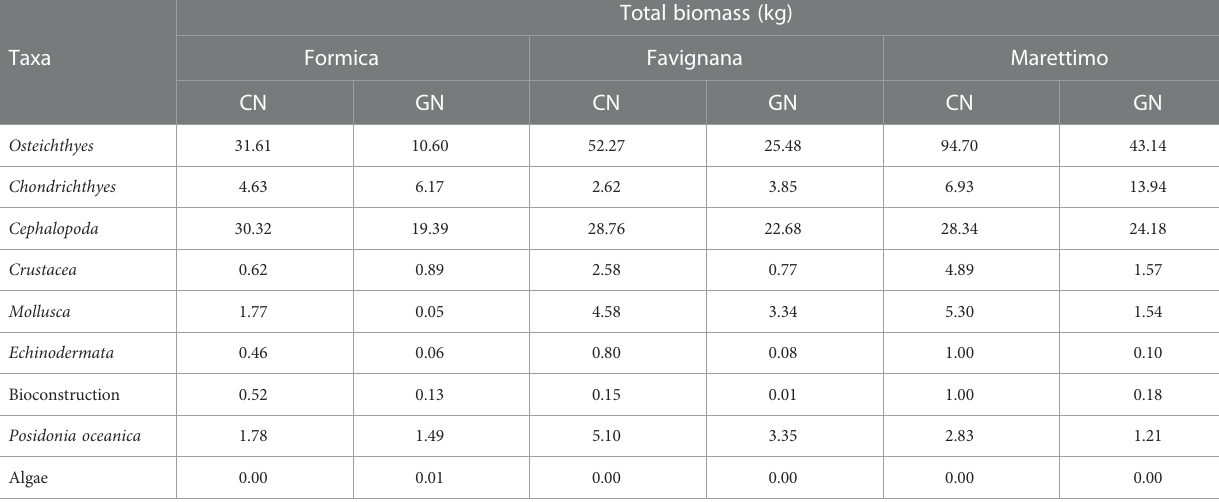
TABLE 1 Biomass of taxa for standard (CN) and modi fi ed (GN) panels per